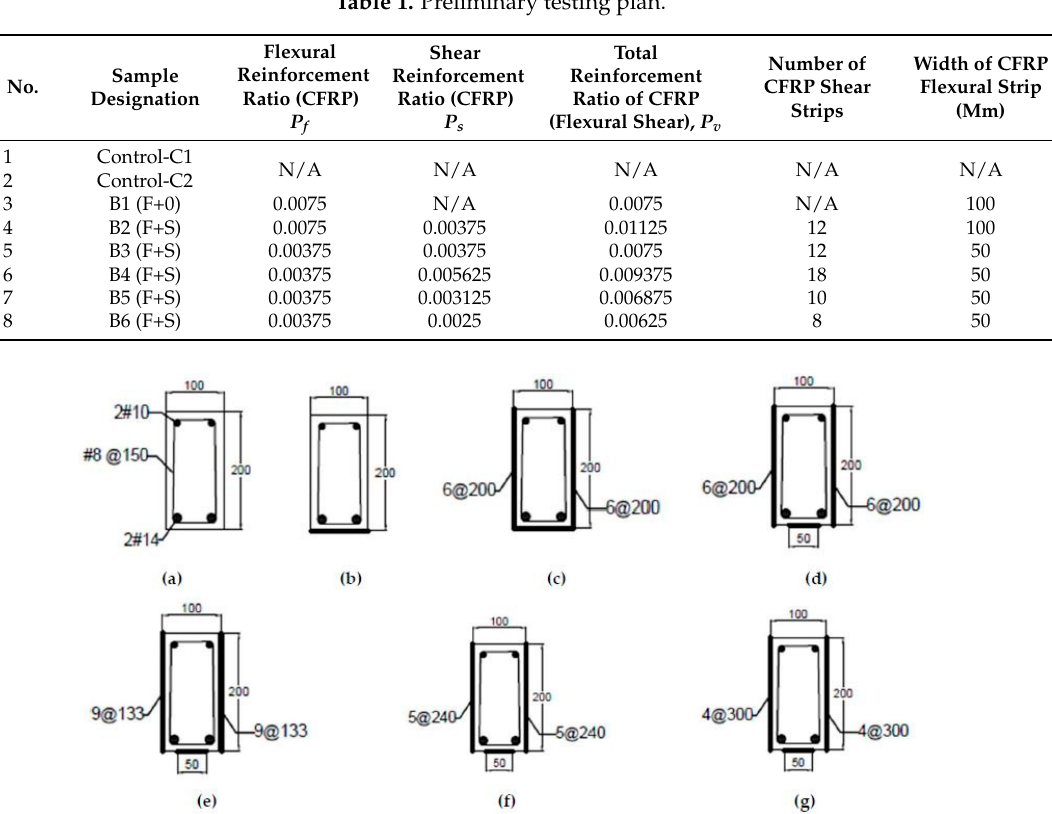
Table 1. Preliminary testing plan.